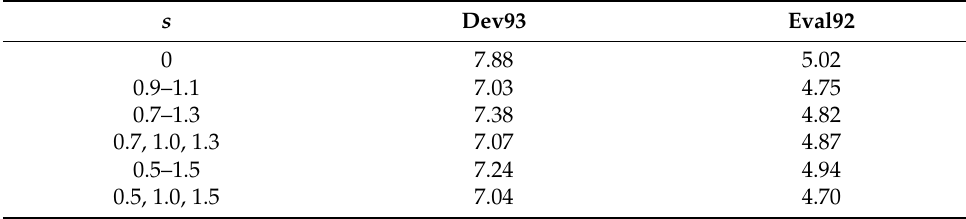
Table 3. WER (%) results of WSJ database according to frame rate s when n = 500. s Dev93